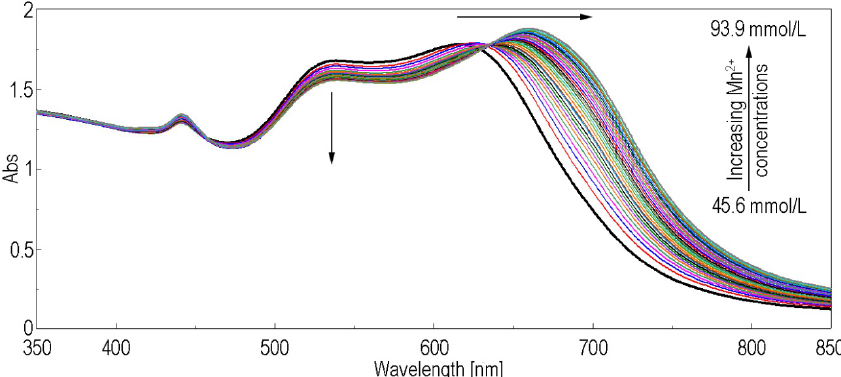
Figure 10. Overlapped UV-Vis spectra for the detection of Mn 2+ using (5-COOH-3MPP)-k-carrageenan-AuNPs hybrid material, in DMF/water.